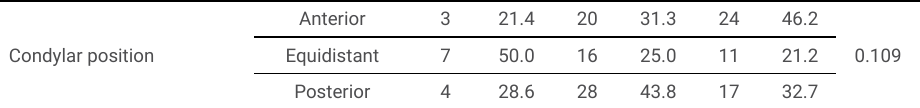
Table 2. Cross tabulation of the occurrence of degenerative changes and muscle signs and the significance of the chi-square test.